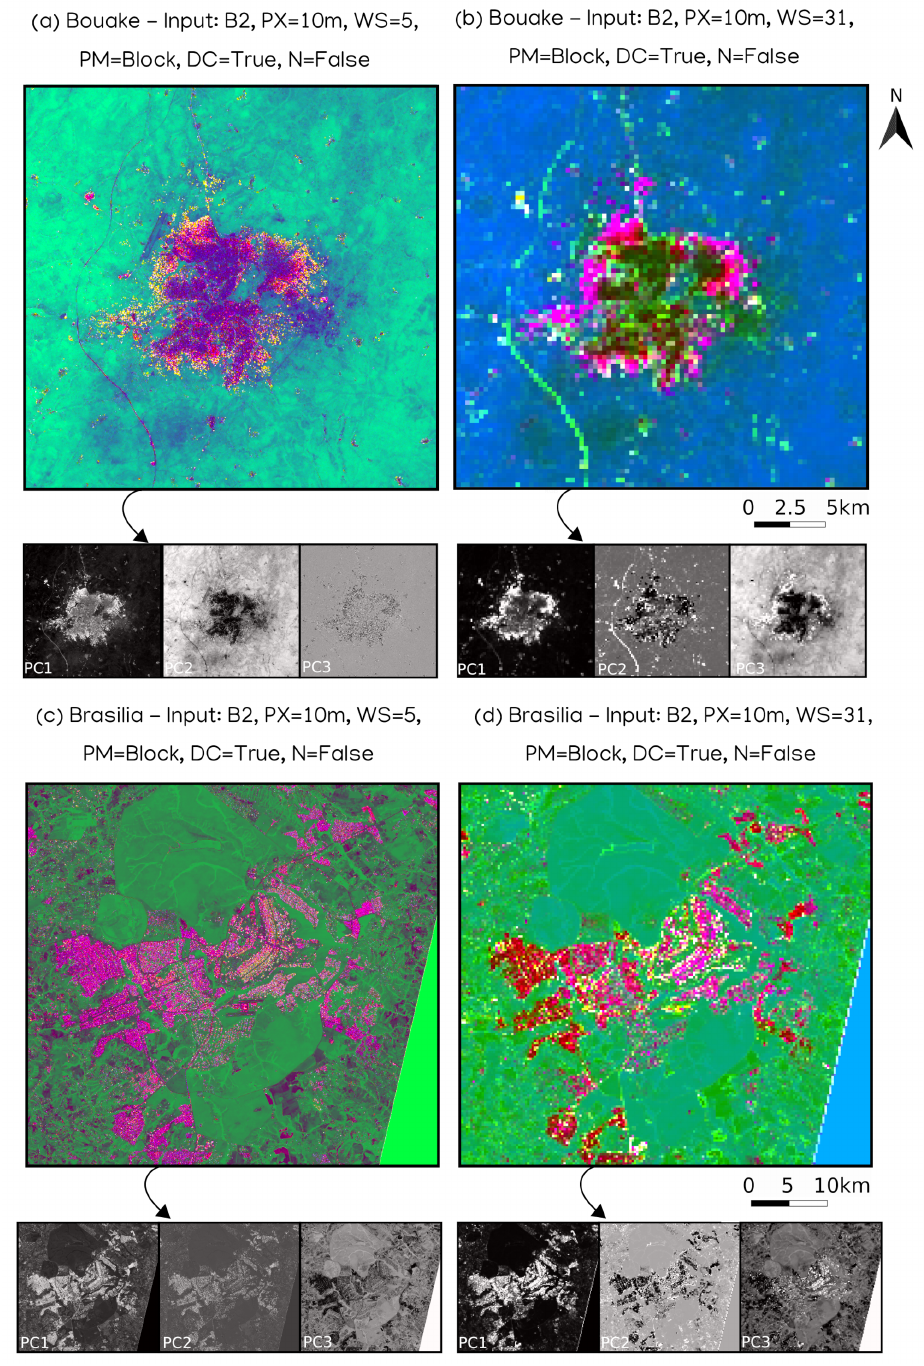
Figure 5. Influence of the window size parameter in the FOTOTEX algorithm for the characterization of urban areas at the macro-scale using Sentinel 2 images on Bouake and Brasilia. ( a ) B2 (blue) sentinel 2 band on Bouake with a window size of 5 pixels, ( b ) B2 (blue) sentinel 2 band on Bouake with a window size of 31 pixels, ( c ) B2 (blue) sentinel 2 band on Brasilia with a window size of 5 pixels and ( d ) B2 (blue) sentinel 2 band on Brasilia with a window size of 31 pixels . (PX = pixel size, WS = window size, PM = partitioning method, DC = DC component, N =